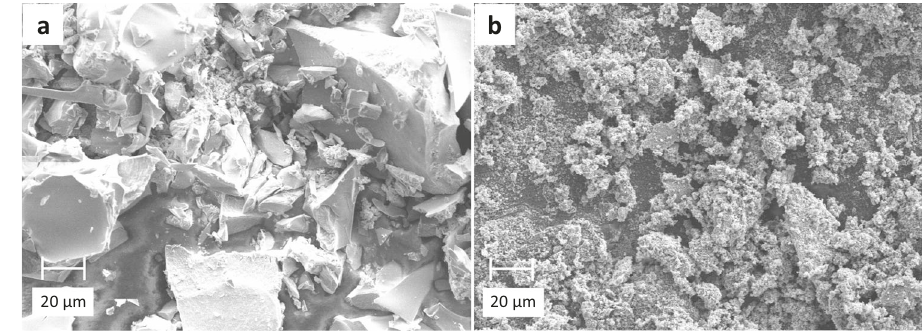
Fig. 3 SEM images of Fe – Mn – K catalyst. a The Fe – Mn – K catalyst precursor; b the used Fe – Mn –